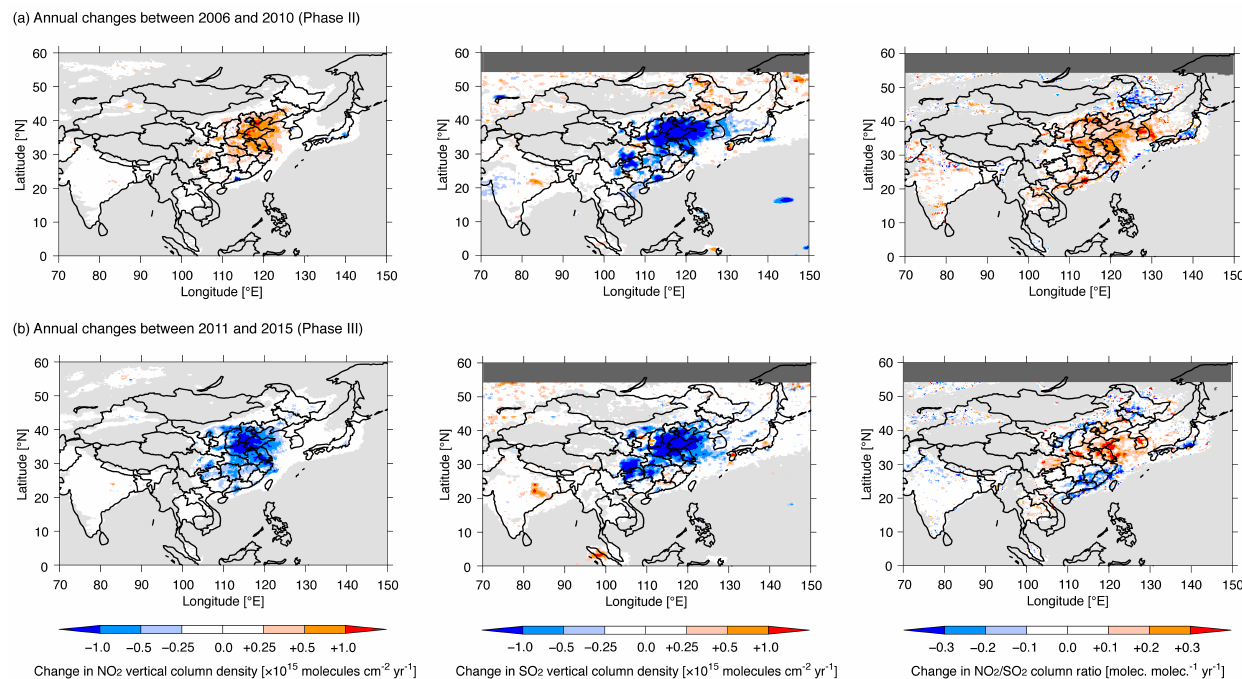
Figure 4. Annual changes based on the linear regression results for the (left) NO 2 column, (center) SO 2 column, and (right) NO 2 / SO 2 column ratio during (a) Phase II and (b) Phase III. Dark-gray cells indicate areas where annual mean calculation could not be performed. If either the NO 2 or SO 2 column value is less than 1.0 × 10 15 moleculescm − 2 , this is indicated by a light-gray cell for